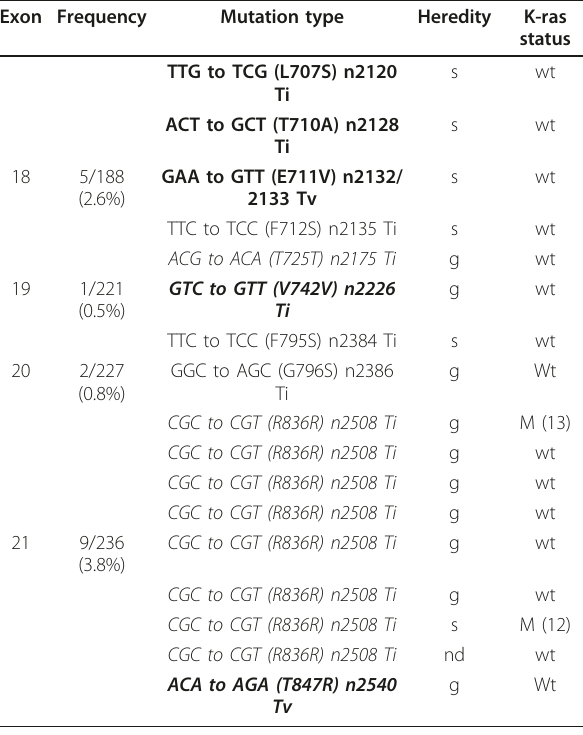
Table 2 Mutations found in EGFR exons 18 to 21